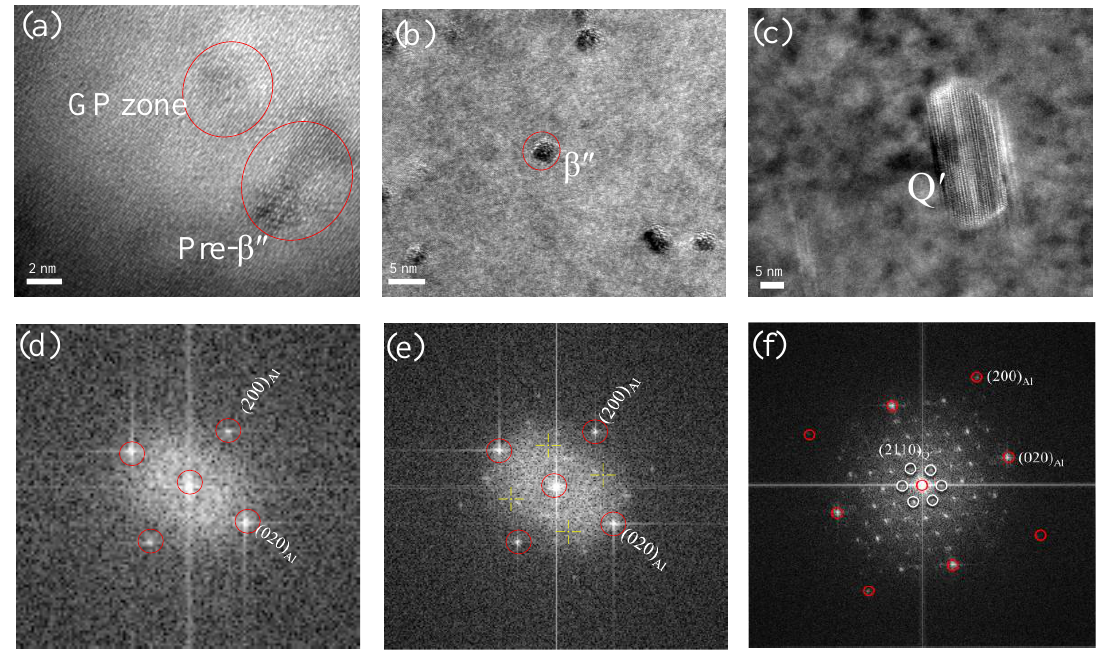
Figure 8. HRTEM images of the cross-section of the precipitates observed from <001> Al in the different exposure conditions: ( a ) as-received, ( b ) 180 °C for 90 h, ( c ) 270 °C for 90 h, ( d – f ) corresponding FFT spectrums of precipitates in ( a – d ), respectively.